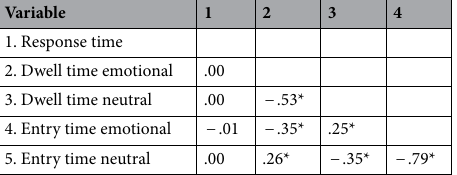
Table 2. Correlations between response time, dwell time and entry time. *p <